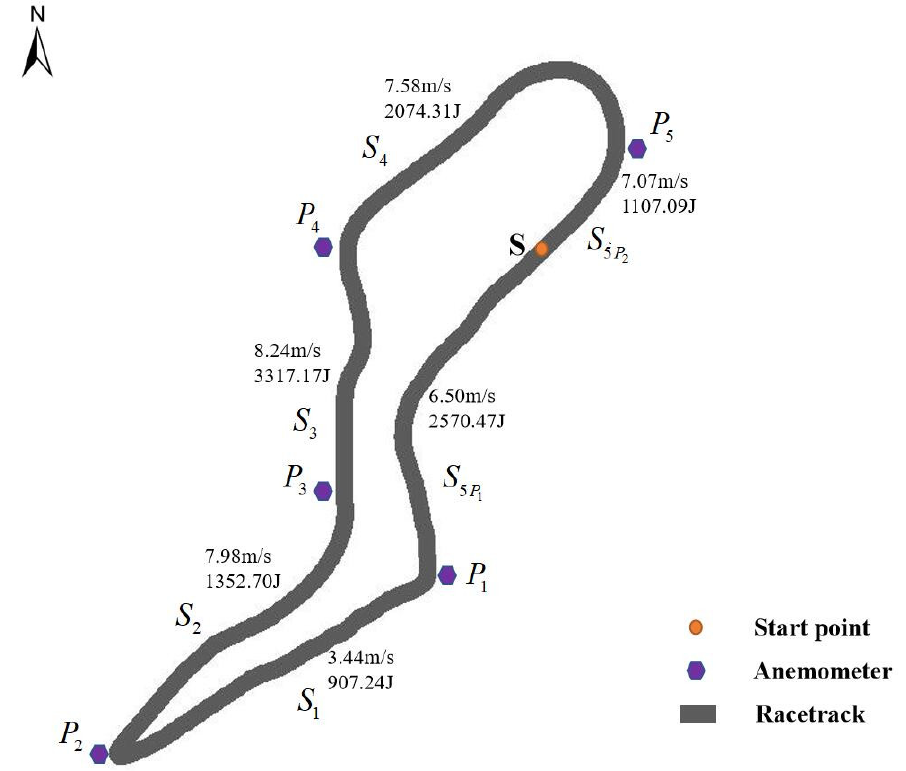
Figure 10. Average speed and corresponding work of the athlete in each stage.